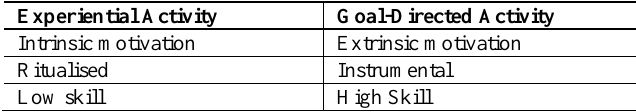
Table 2: Summary of experiential and goal-directed